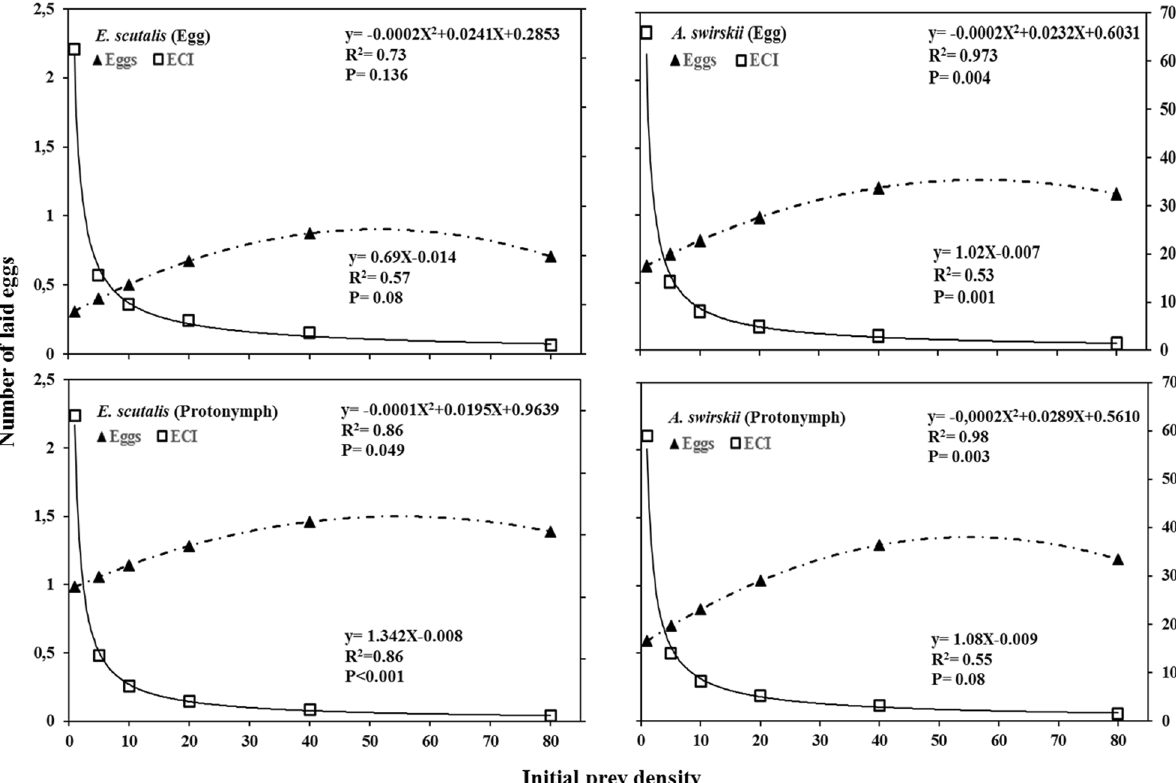
Fig. 2 Numerical response and ECI factor curves of Amblyseius swirskii and Euseius scutalis and their relationship with different egg and protonymph densities of Eutetranychus